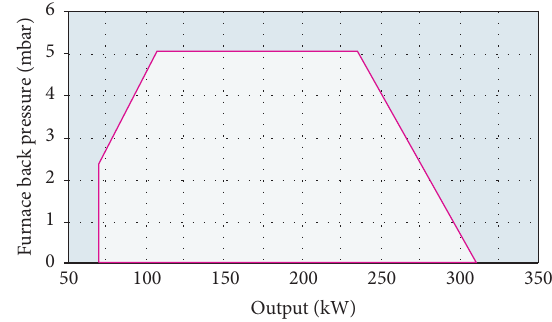
Figure 2: Burner working curve.